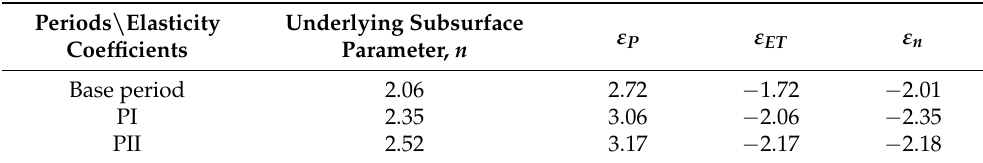
Table 5. Elasticity coefficients of each hydrological element in the Weihe River basin at different periods.